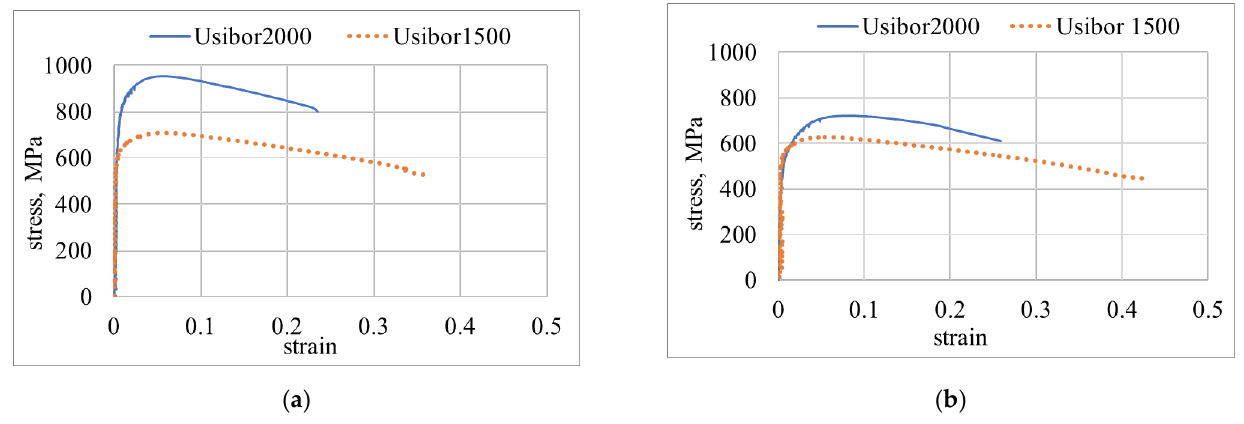
Figure 16. ( a ) Stress – strain curves for the two UHSS in the condition of heated tools temperature of 430 °C; ( b ) Stress – strain curves for the two UHSS in the condition of heated tools temperature of 500 °C.